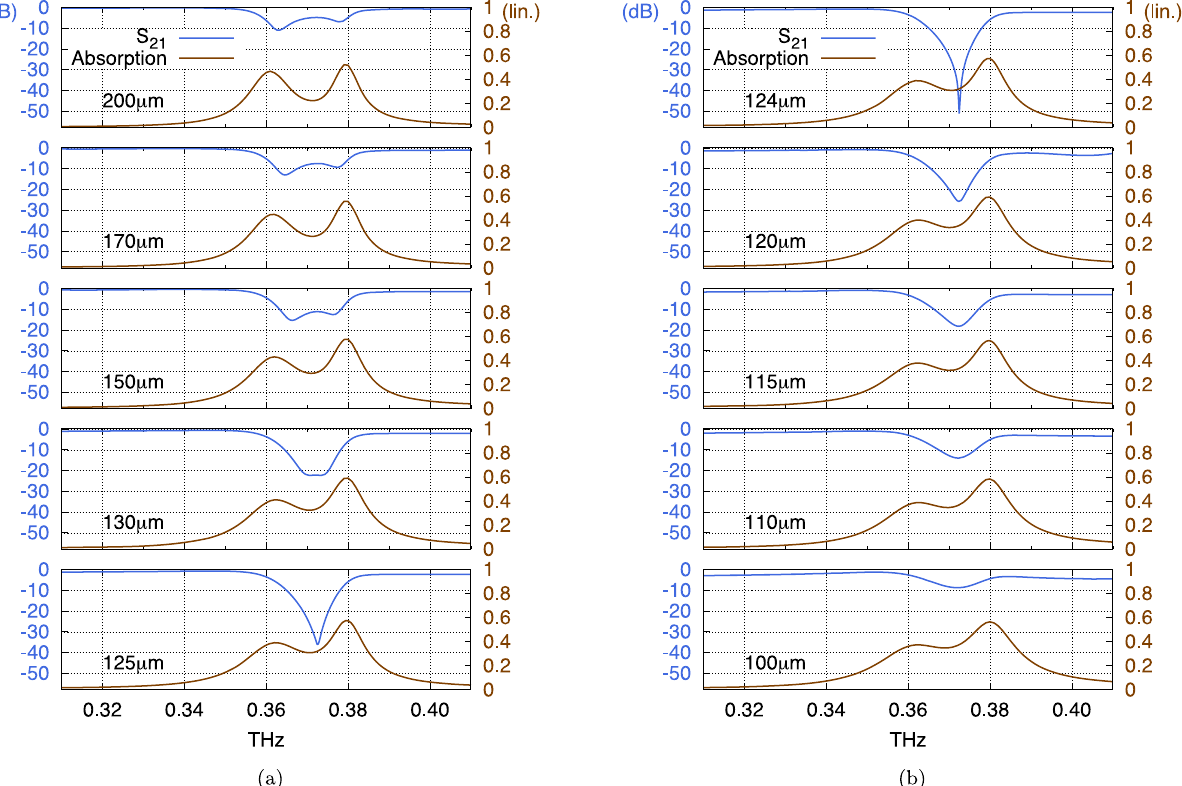
Fig. 8. Effect of spatial mode coupling: S 12 parameter (log. scale (dB)) and absorption A (linear scale (lin.)) for several values of distance p 2 between two resonators. The side lengths of the resonators are a m =60 m m and a e = 90 m m. (a) Out of frequency degeneracy regime (125 (cid:3) p 2 (cid:3) 200 m m); (b) in frequency degeneracy regime (100 (cid:3) p 2 (cid:3) 124 m m). The merged minima of the S 12 parameter attain very weak values ( ≲ (cid:1) 51dB) when p 2 = p 2 c =124 m m, which correspond to the minimum of the refractive index n eff